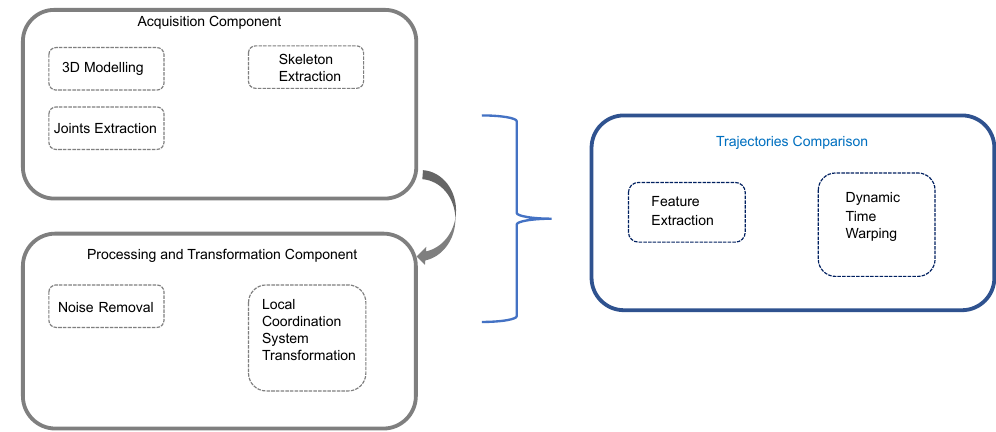
Figure 1. A block diagram of our proposed methodology.